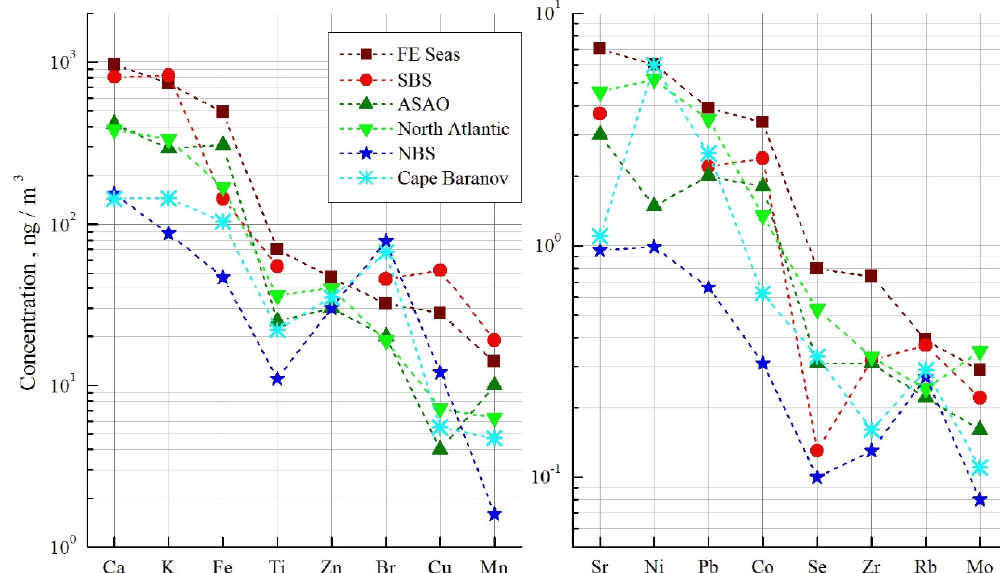
Figure 12. Comparison of the average elemental composition of aerosol in different regions: in “ TransArctic–2019 ” expeditions (NBS, SBS, ASAO, and FE seas); at “ Cape Baranov ” station [13]; in the North Atlantic (71st cruise of RV Akademik Mstislav Keldysh ) [29].